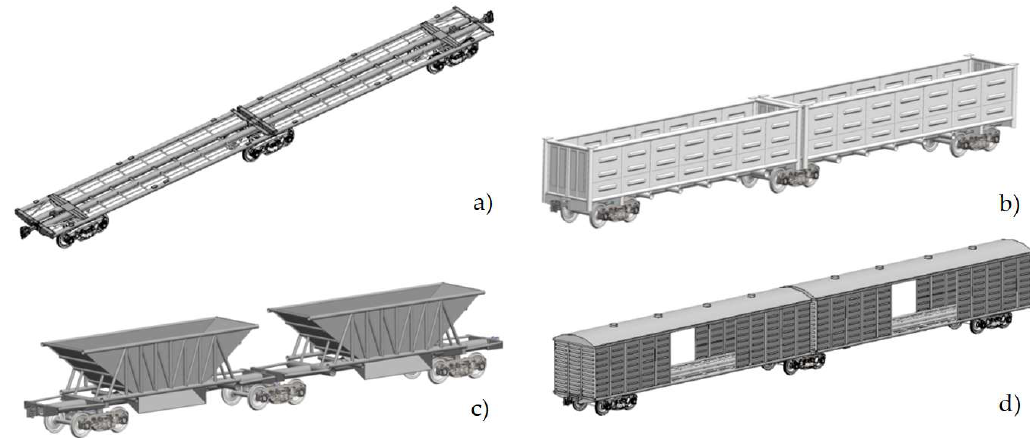
Figure 3. Spatial computer models of freight wagons: ( a ) flat wagon, ( b ) open wagon, ( c ) boxcar, and ( d ) hopper wagon.